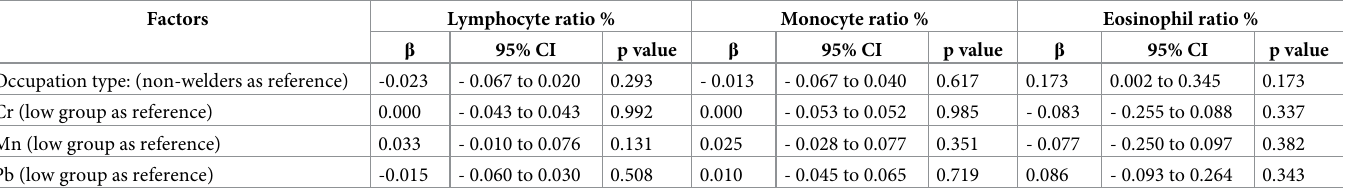
Table 6. Effects of welding fume exposure on blood hemostatic